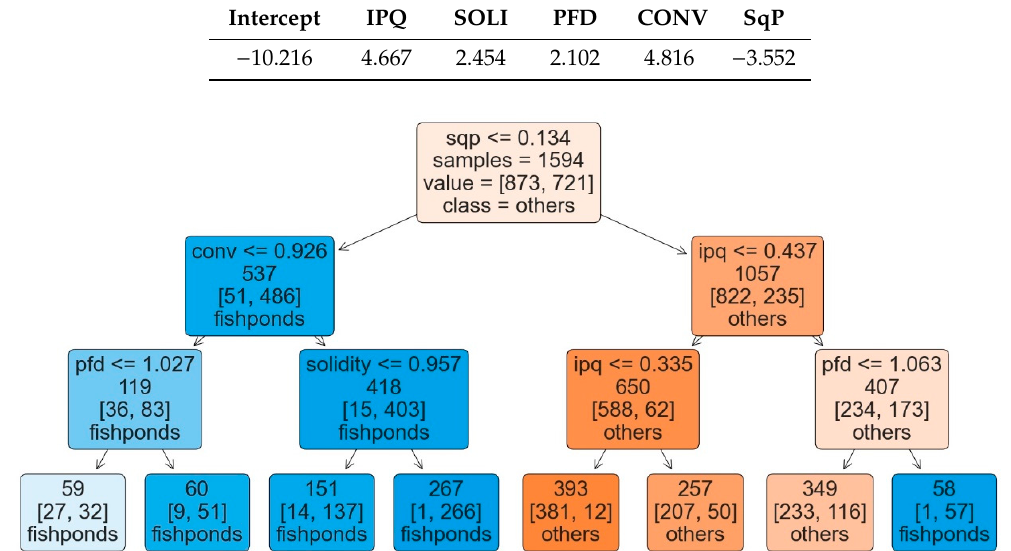
Table 5. Coe ffi cients of OBFs using the optimal LR model.